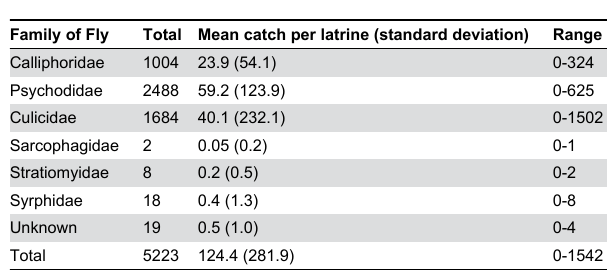
Table 3. Families of flies (Diptera) collected in latrine exit-